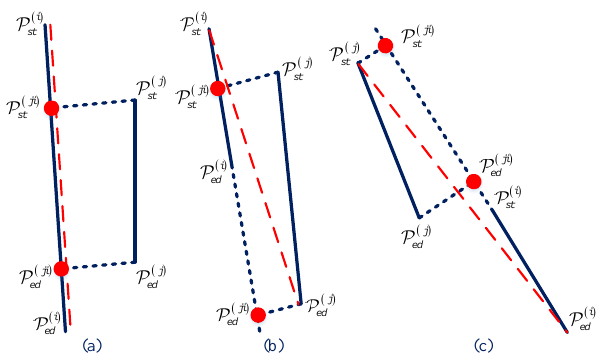
Figure 6. Three positions of two lines with red dashed lines indicating the line combination result ( a ) containing ( b ) overlap ( c ) disjoint.